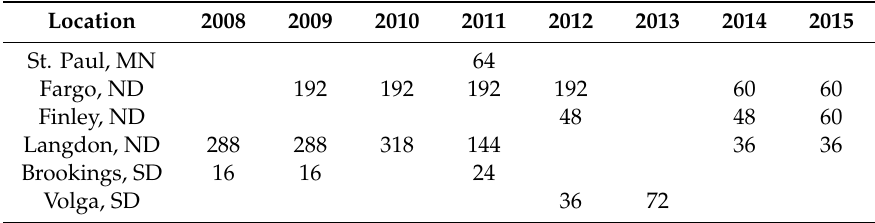
Table 2. Number of plots observed, by locations in USA and